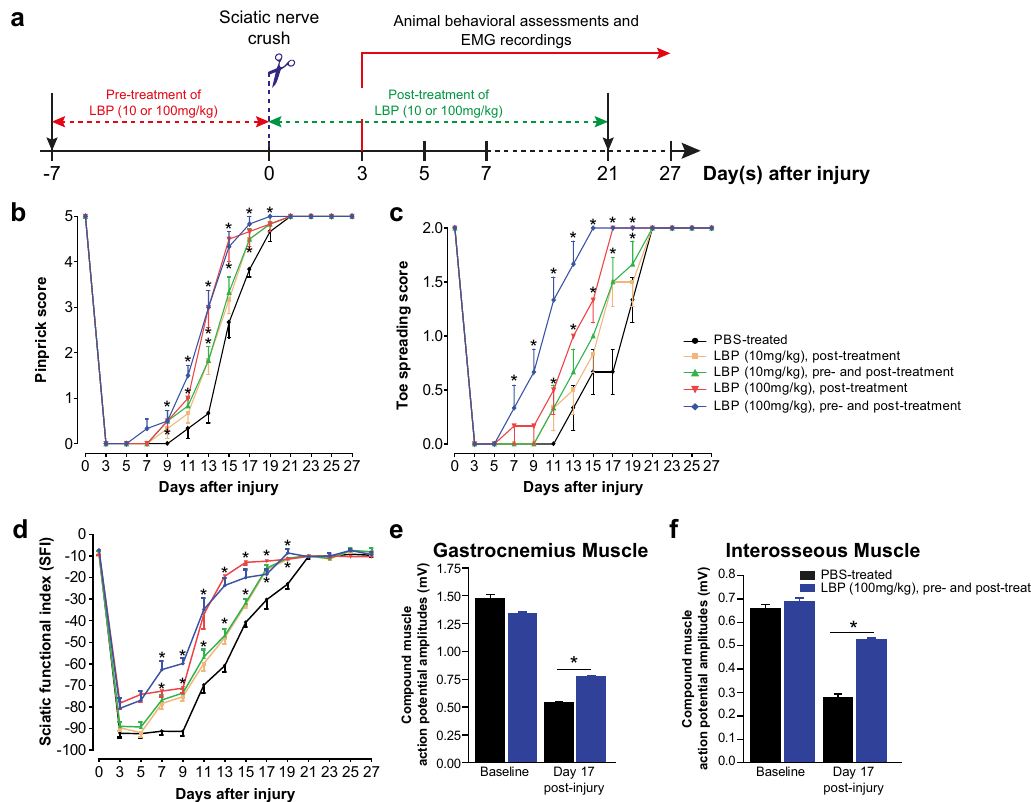
Fig. 2 LBP accelerates function recovery after a single sciatic nerve crush (SNC) injury in a dose-dependent manner. a Schematic diagram illustrating the experimental timeline for SNC injury and LBP (10 or 100 mg/kg) treatment paradigm. Adult mice received LBP orally once daily for 7 consecutive days (pre-treatment) and 21 consecutive days (post-treatment) immediately after SNC. b The bene fi cial effect of 10 mg/kg and 100 mg/kg LBP was enhanced slightly in mice with 7-day pre-treatment and 21-day post-treatment, when compared with 21-day post- treatment alone. c LBP-treated mice (100 mg/kg, pre- and post-treatment) showed the fastest recovery of toe spreading re fl exes from days 7 to 19 post-injury when compared with other treatment groups. d Gait movement as assessed by sciatic function index, was markedly improved in LBP-treated mice, when compared with PBS-treated controls. e, f Improved compound muscle action potential amplitudes of both proximal (gastrocnemius; e ) and distal (interosseous; f ) muscles were observed in LBP-treated mice (100 mg/kg pre- and post-treatment) at day 17 post-injury, when compared with PBS-treated controls. Mean ± SEM ( n = 5 – 6 per group); * P < 0.05, two-way repeated measures ANOVA followed by post hoc Bonferroni